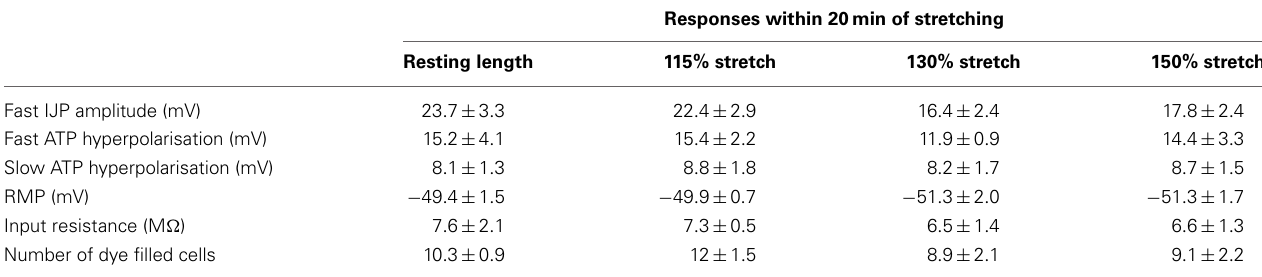
amplitude over the following hours. Dye coupling, measured by spread of carboxyfluorescein injected from the recording electrode, also increased in parallel. After the edges of the preparation were re-cut (vertical dashed line) both IJP amplitude and dye coupling reduced significantly, recovering gradually with